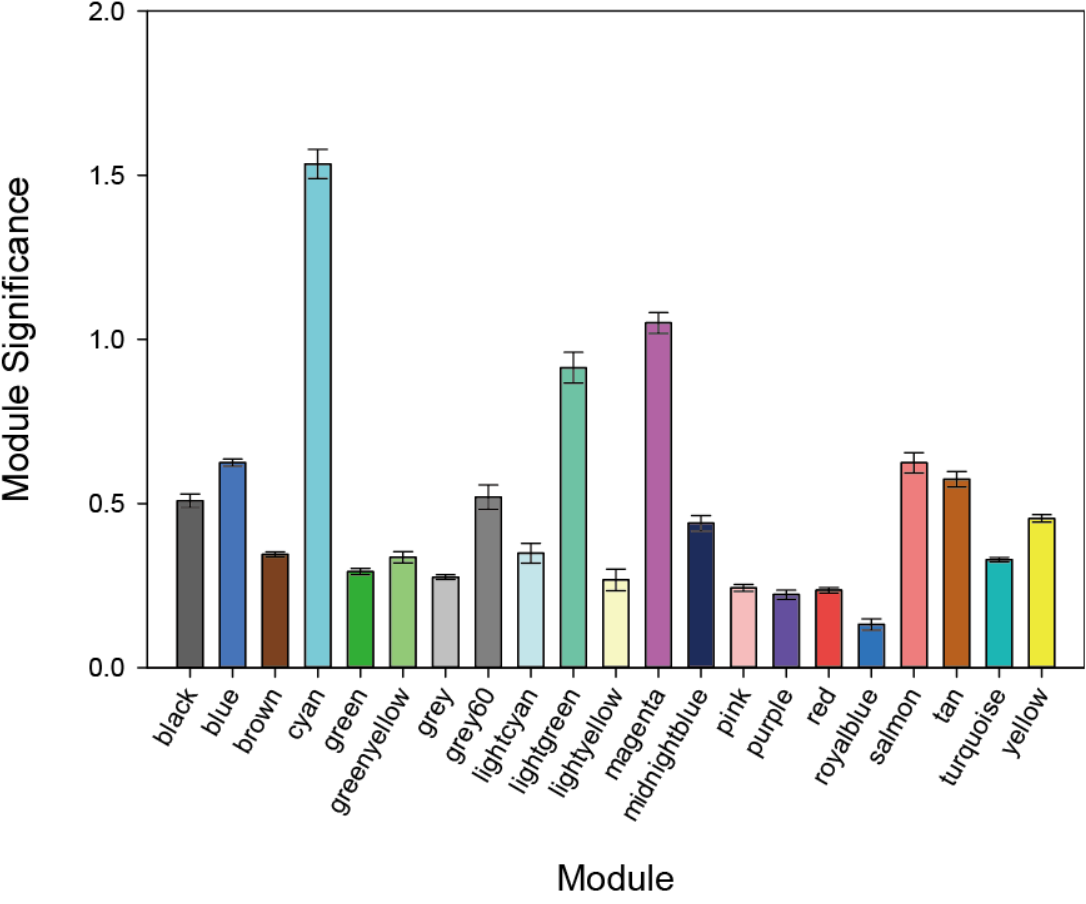
Figure 2. Each module’s MS (module significance) value. Both the cyan and magenta modules were highly enriched with differentially expressed genes (DEGs). Columns: mean values. Bars: standard error of the mean (SEM).